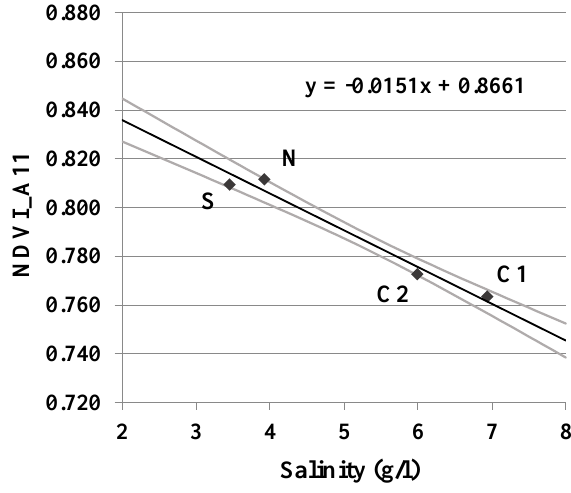
Figure 8. Correlation between the average NDVI_A11